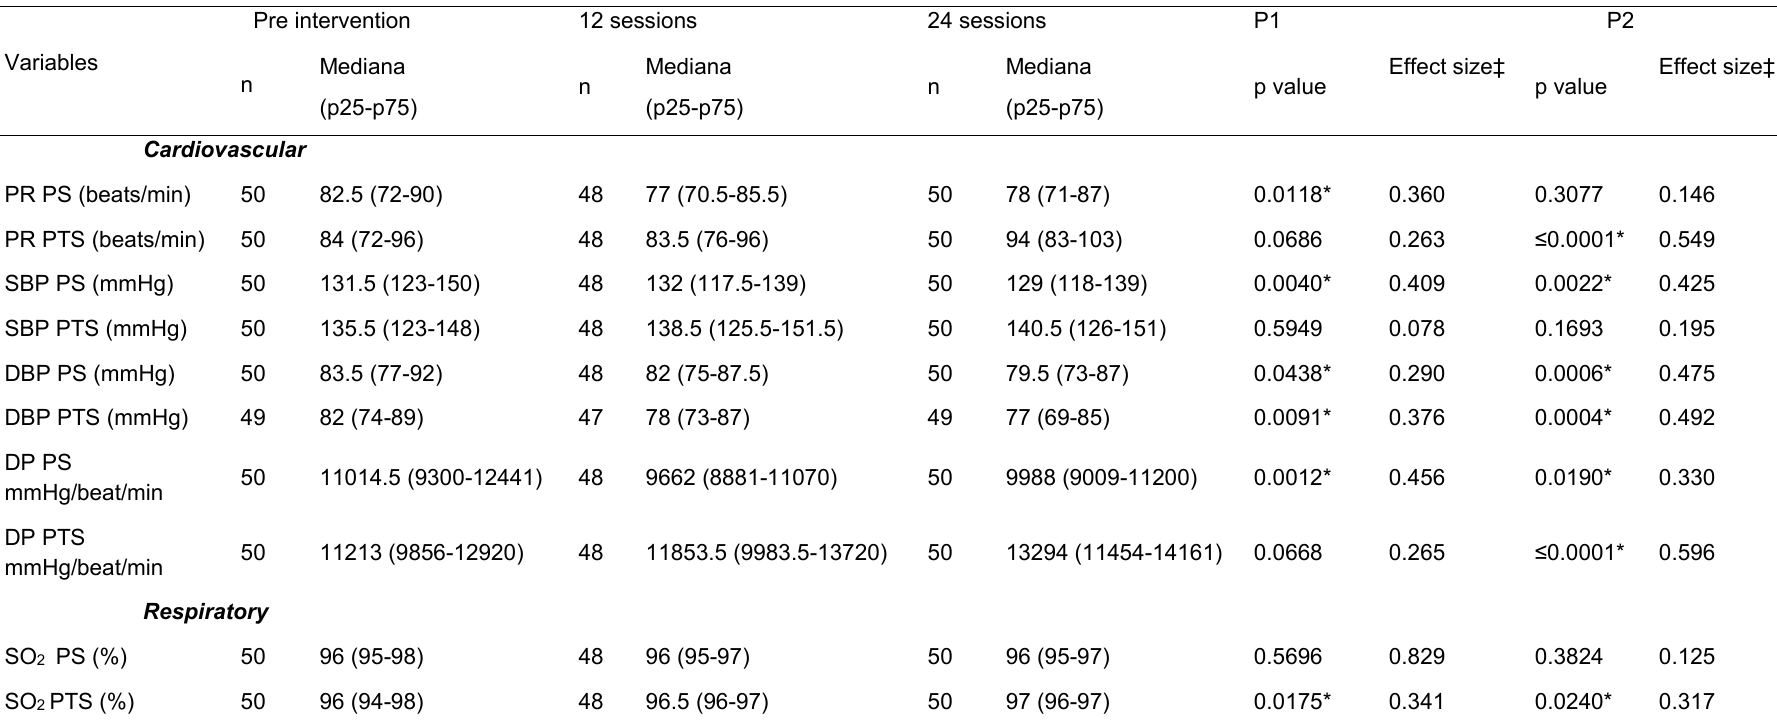
Modifications Cardiovascular and Respiratory Parameters at 12 and 24